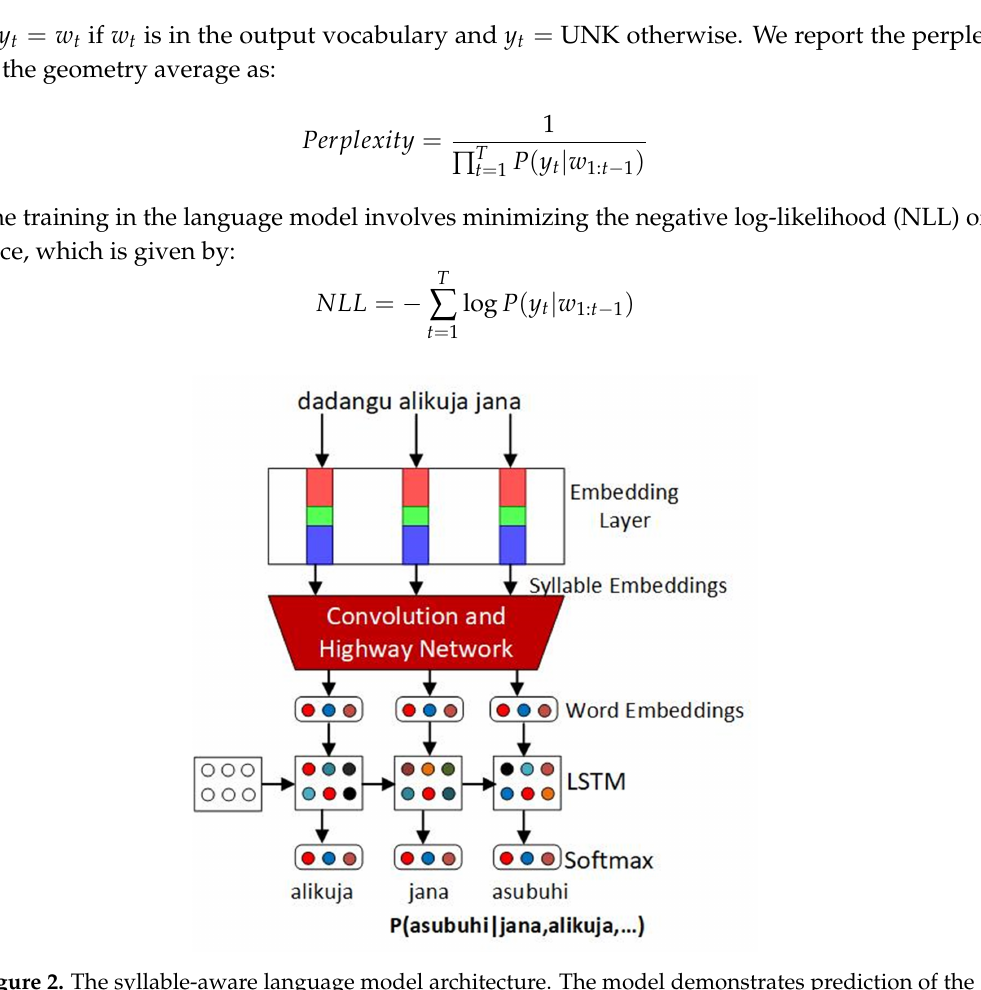
Figure 2. The syllable-aware language model architecture. The model demonstrates prediction of the next word asubuhi from its